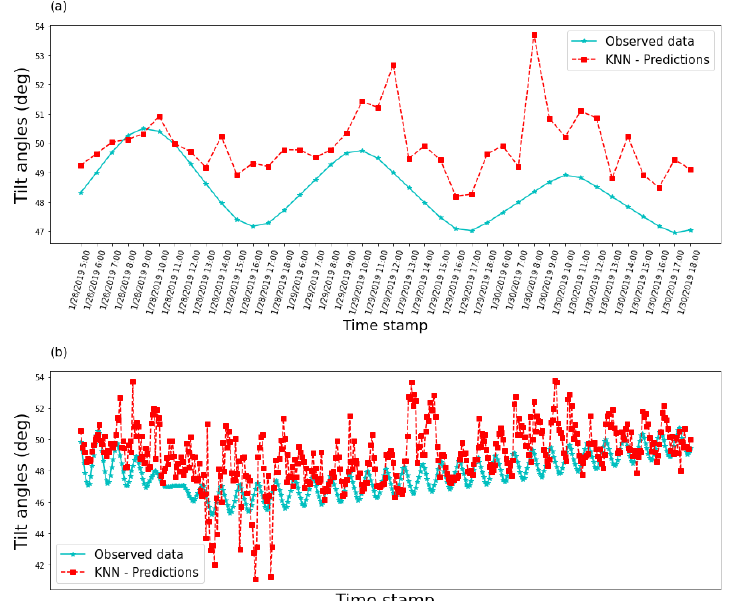
Figure 11. KNN prediction results for a random selection of ( a ) 3 days and ( b ) 31 days of the observed dataset.